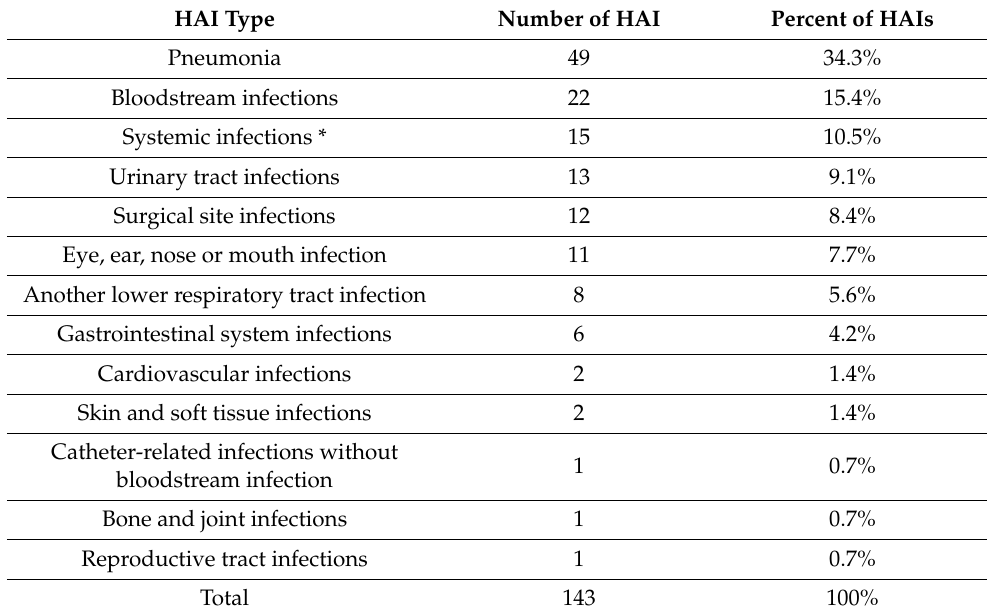
Table 1. Distribution of hospital-acquired infections in regards to the site of infection.